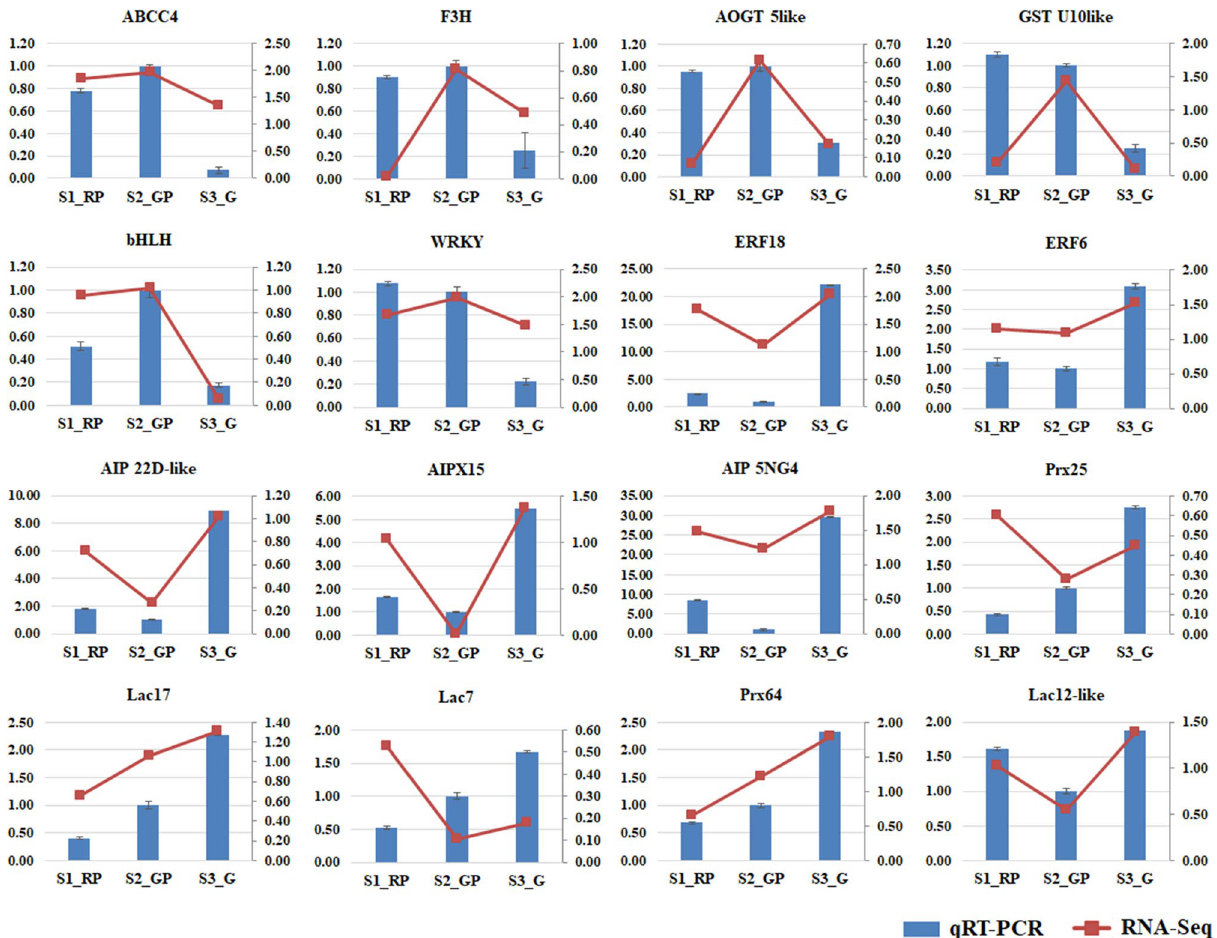
Figure 8. The expression profiles of 16 DEGs as determined by qRT-PCR and their correlation with RNA-seq expression